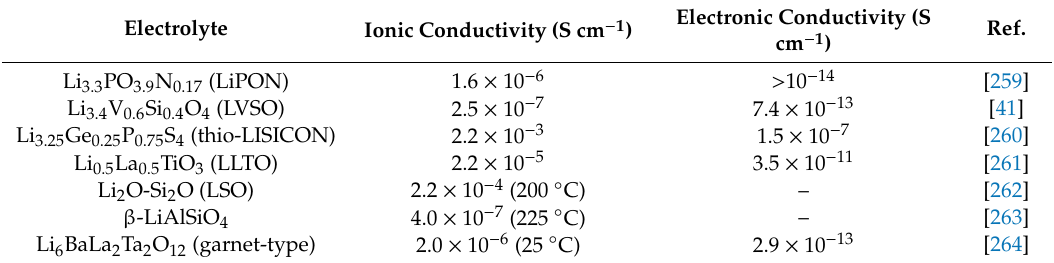
Table 8. Electrical properties of PLD-grown solid-electrolyte thin